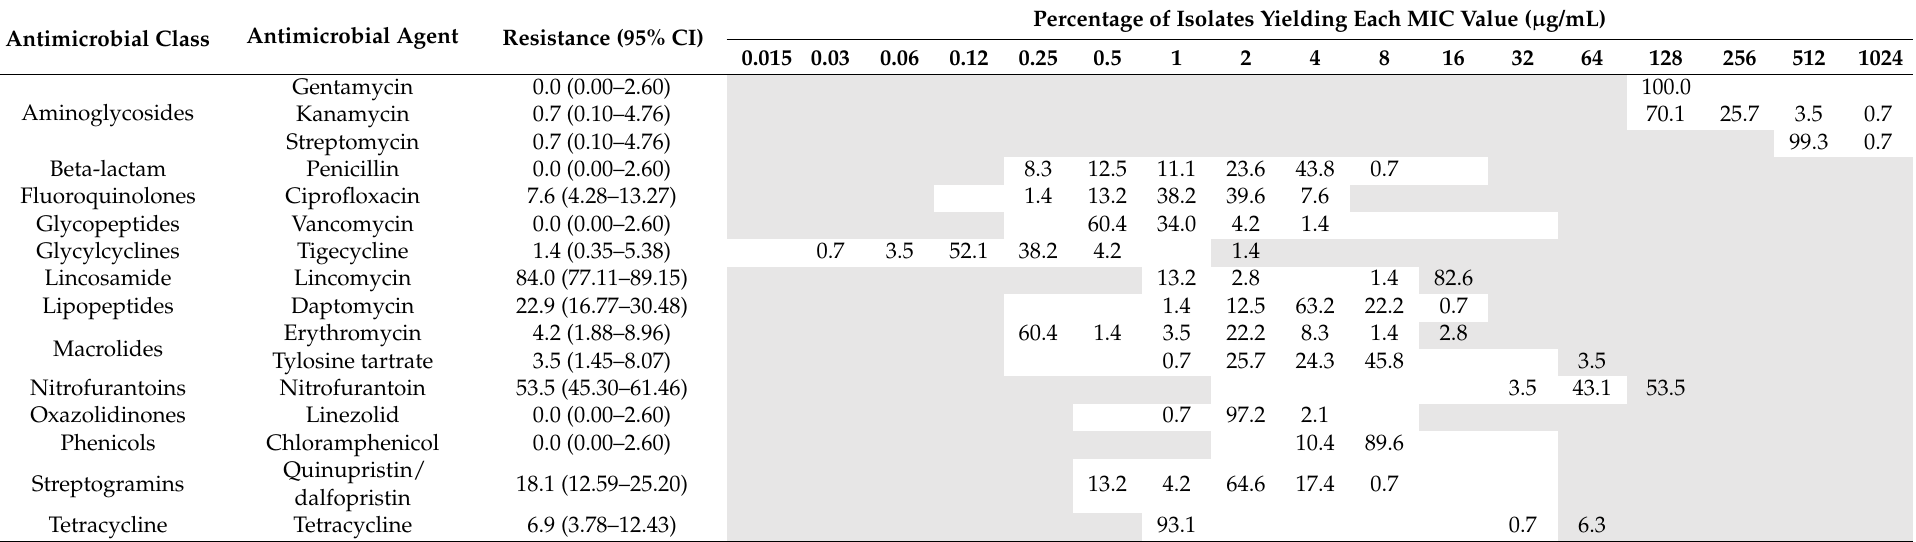
Table 3. Antimicrobial ( n = 16) minimum inhibitory concentration (MIC) distribution data obtained for 144 Enterococcus spp. isolated from 150 rectal faecal samples obtained at feedlot exit. The vertical line within each MIC distribution indicates the resistance breakpoint (see Table 1) for each antimicrobial except for tigecycline, where it indicates the susceptible